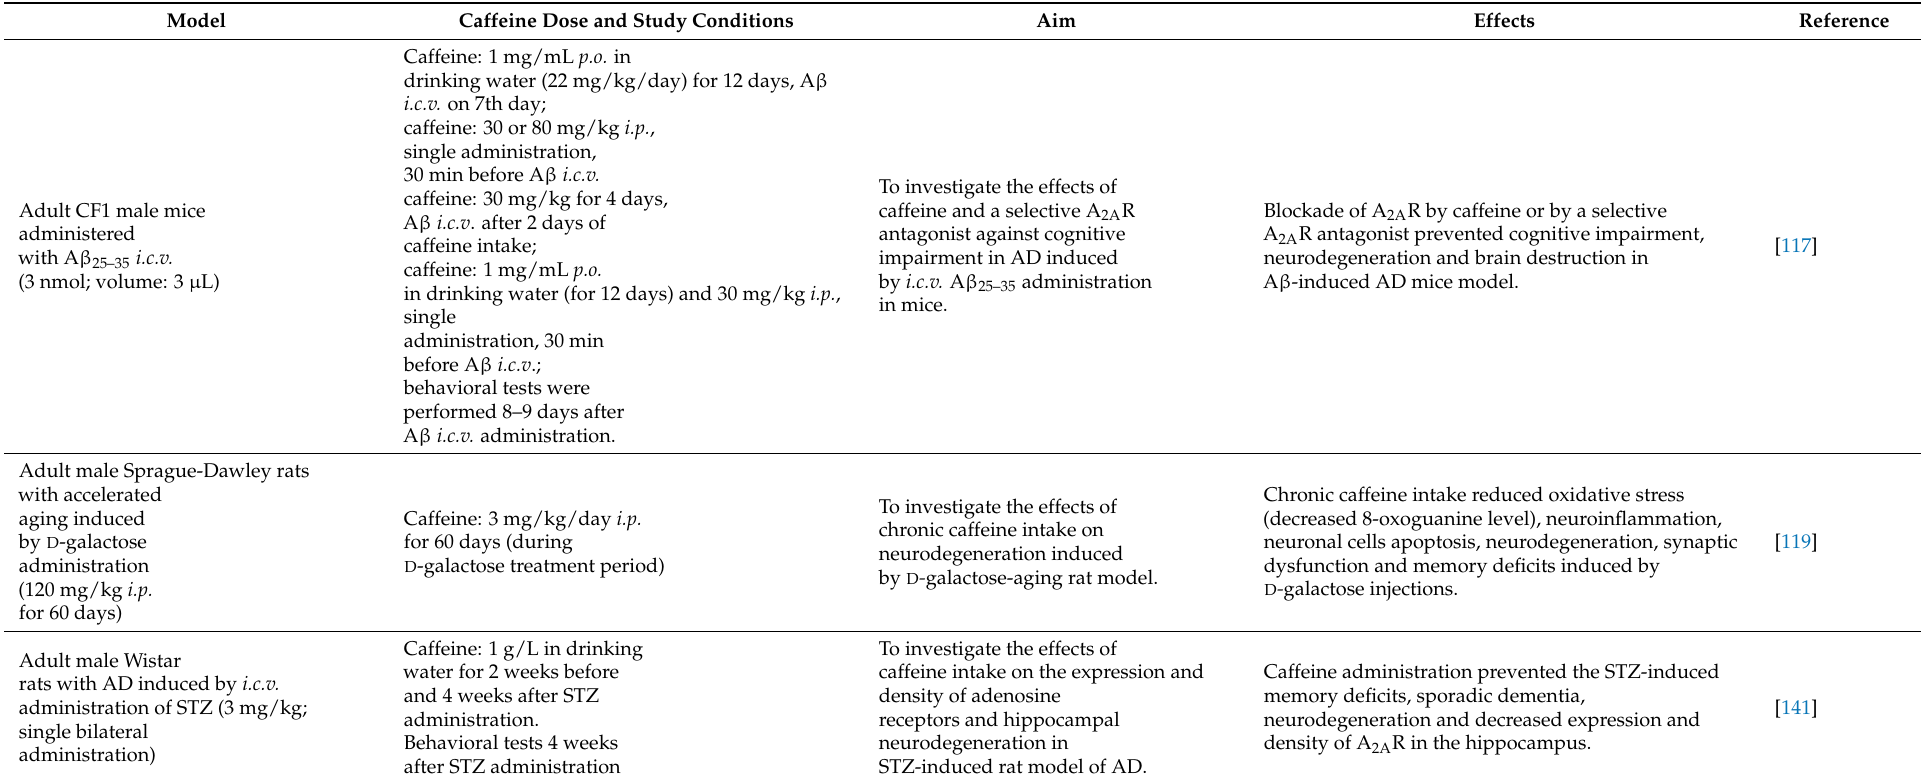
Table 2. Non-transgenic